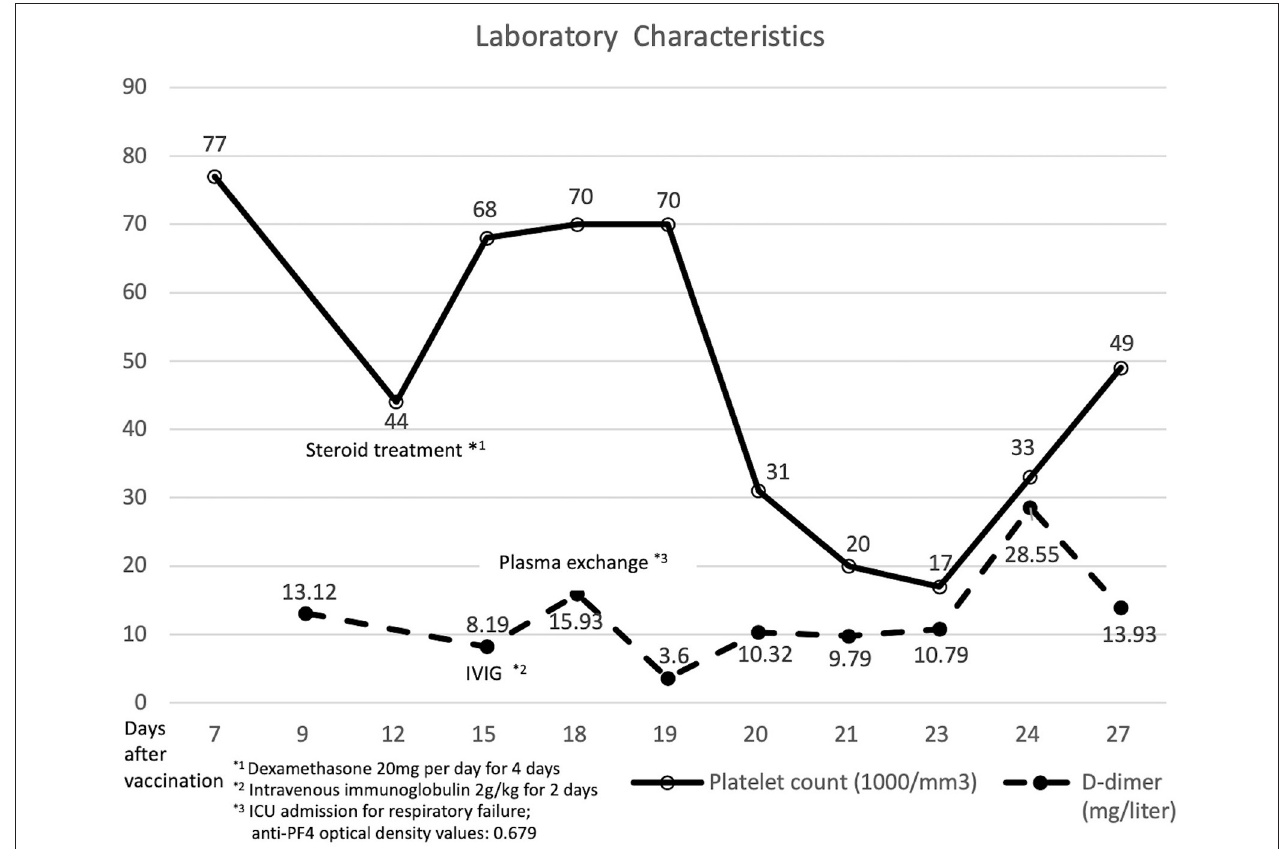
FIGURE 2 | Laboratory data and clinical course of the patient with vaccine-induced immune thrombotic